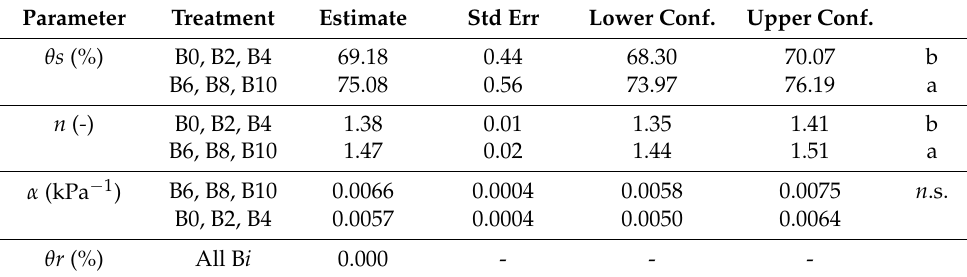
Table 5. Results of the “stepwise” procedure applied in performing the parameter fitting of the van Genuchten model to the six soil–biochar mixtures (Bi treatments). Standard error of the estimates, together with their confidence intervals at 95% of probability are also